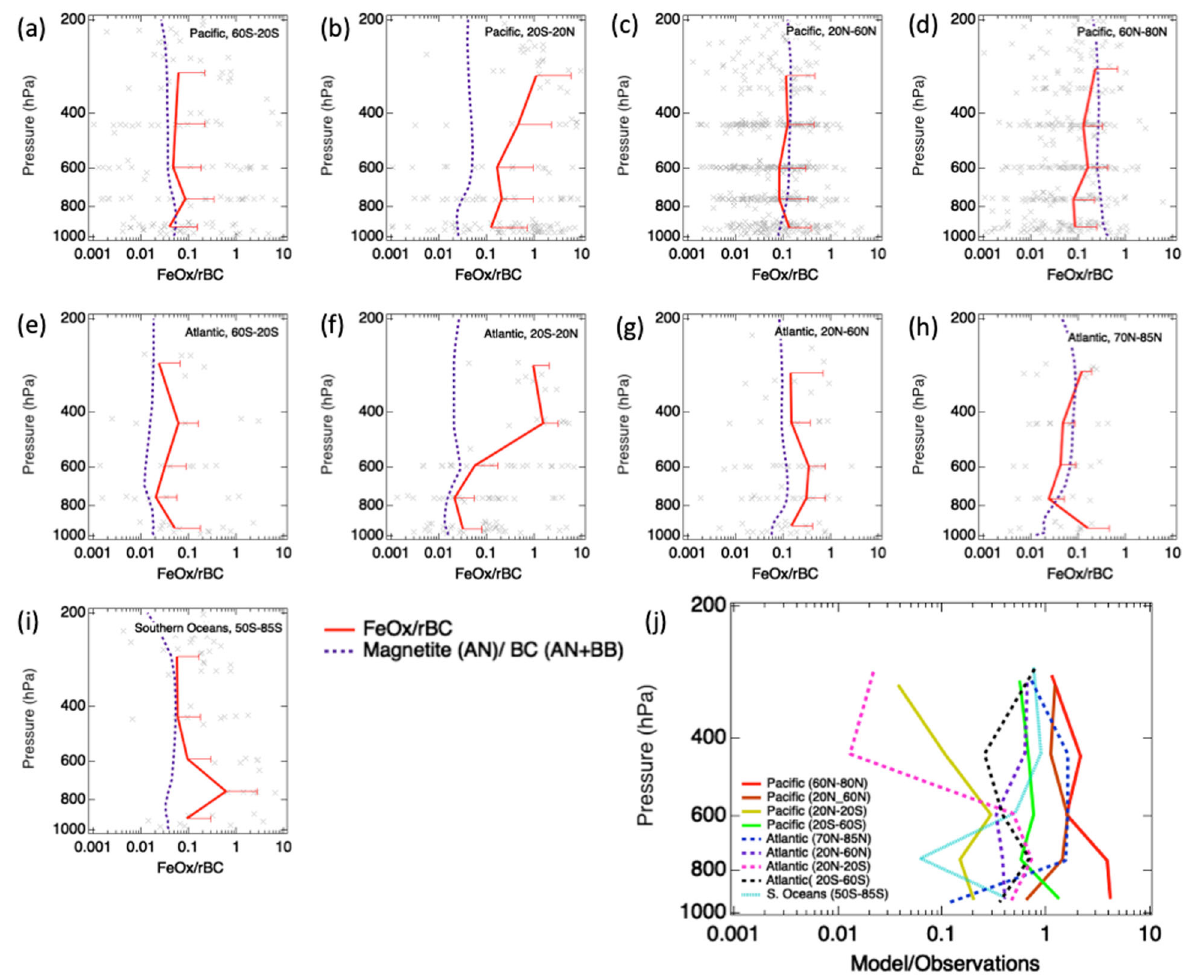
Fig. 7 Comparison of anthropogenic FeO x /rBC observations to global model estimates of magnetite/BC. Regional average vertical pro fi les ( a – i ) for the observed anthropogenic FeO x /rBC (solid red lines) binned to 160 hPa pressure bins, compared with annual averaged vertical pro fi les from the CAM5 model for AN magnetite/(AN + BB) BC (dashed purple lines). Vertical pro fi les include data from HIPPO 2 – 5 and ATom 1-4 campaigns. To determine vertical pro fi les of the ratio of FeO x /rBC from observations, average vertical pro fi les for FeO x and rBC are calculated for each region (Fig. 6 and Supplementary Fig. 16) and then divided to determine the ratio at each altitude level, as we assume that remote regions are well-mixed. Error bars for the ratio are determined by propagation of uncertainty, under the assumption that errors between observed FeO x and rBC concentrations are uncorrelated. Gray crosses show observations for the ratio binned during individual vertical sampling periods; bins where FeO x concentration is 0 are not shown, but are included in the average in each pressure bin for the regional average FeO x vertical pro fi les. The ratio between the model predictions and the SP2-observed ratio is shown in ( j